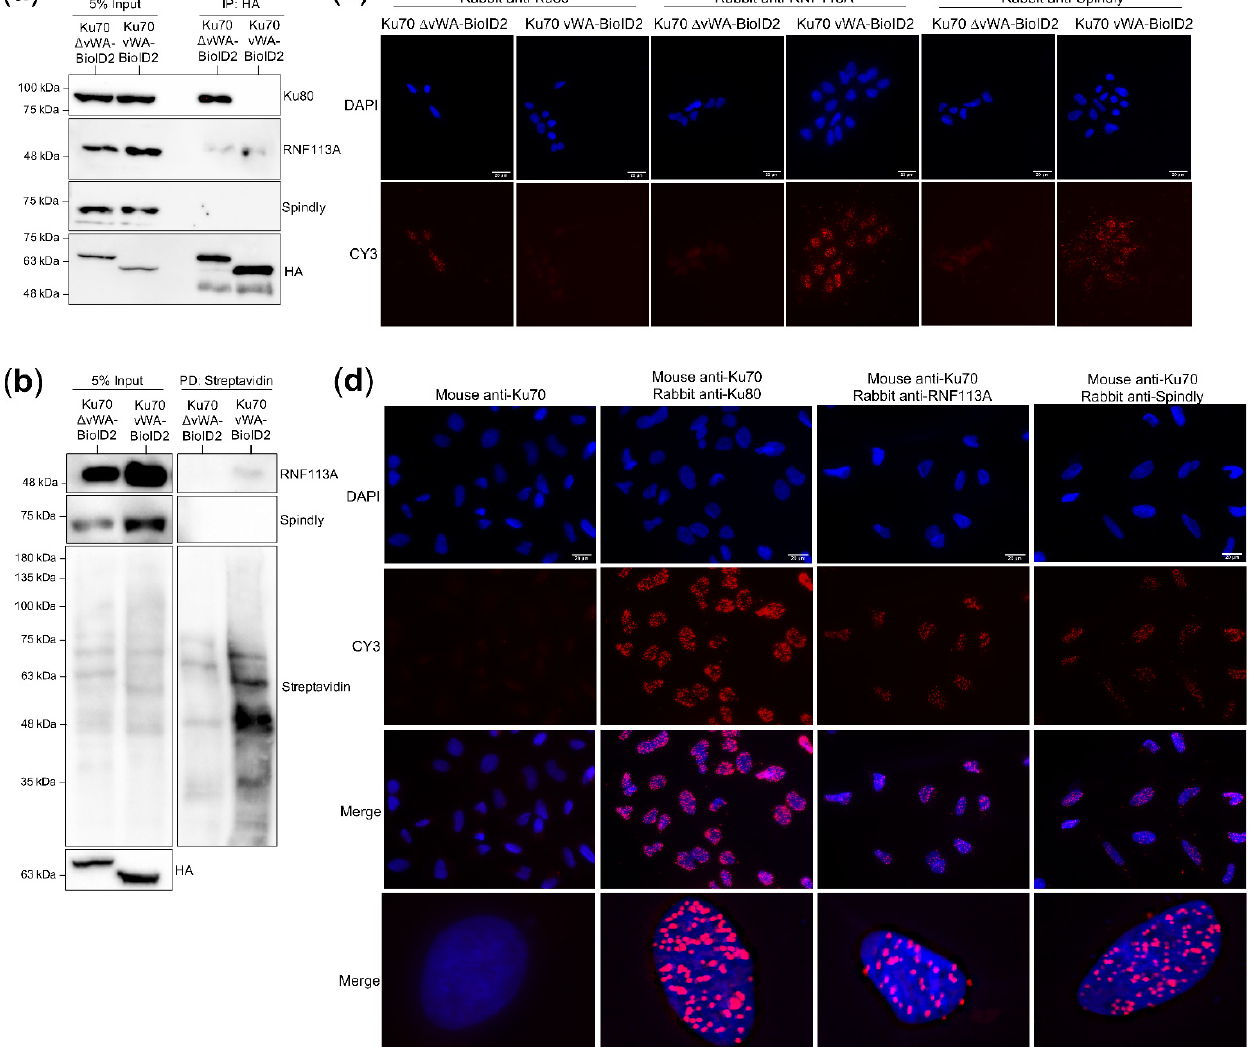
Figure 6. Validation testing of RNF113A and Spindly as Ku70 vWA-specific interactors; ( a ) Ku70 vWA-specific interactor nuclear protein extract (500 µ g) co-immunoprecipitation ( n = 3); ( b ) Small-scale streptavidin pull-down (1 mg) of biotinylated HEK293 whole cell extracts ( n = 2, technical replicates); ( c ) PLA of Ku70 vWA- and Ku70 vWA-BioID2-HA stable HEK293 cell lines using mouse anti-HA and rabbit Ku80, RNF113A, or Spindly ( n = 3); ( d ) PLA of HeLa cells detecting endogenous proteins using mouse anti-Ku70 and rabbit Ku80, RNF113A, or Spindly ( n = 3). Images taken at 40 × magnification with white bar denoting 20 µ m. Bottom panels are enlarged images of nuclei selected from the panels above. Quantification analysis for the average number of nuclear PLA foci can be found in Figure S5.